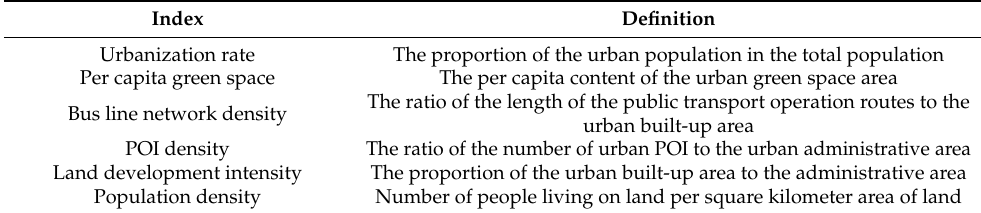
Table 2. Urban space dimension